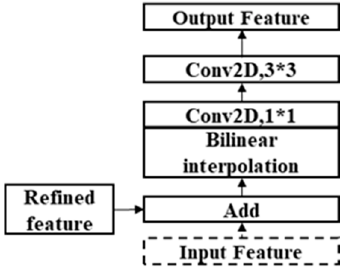
Figure 7. Upsampling